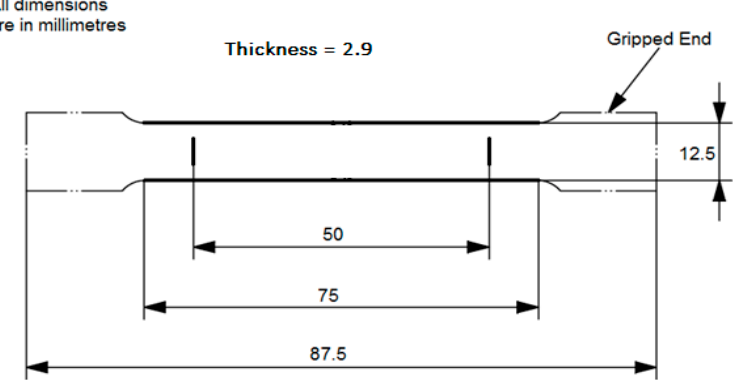
Figure 3. Dimensions of dog bone specimens.